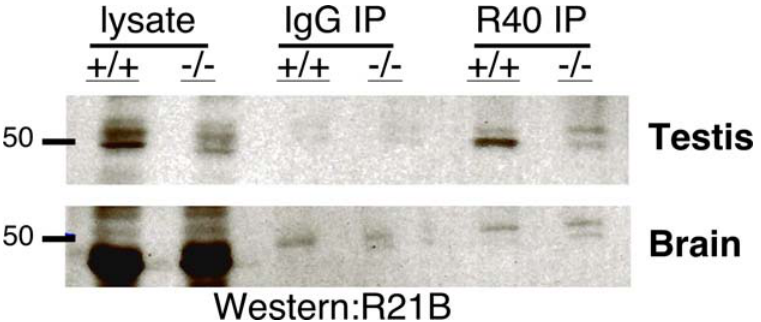
Figure 4. Sperm sAC isoforms are not detected in brain. Immunoprecipitations (IP) using mAb R40 or isotype-matched IgG control antibody from detergent solubilized whole cell extracts (lysates) of testis (top) or brain (bottom) from wild type or Sacy tm1Lex /Sacy tm1Lex mice were subjected to Western analysis using biotinylated R21 mAb. The sharp band at , 50 kDa in the R40 IP from wild type testis is distinct from the faint, background bands found in Sacy tm1Lex /Sacy tm1Lex mice and in the control IgG IP.